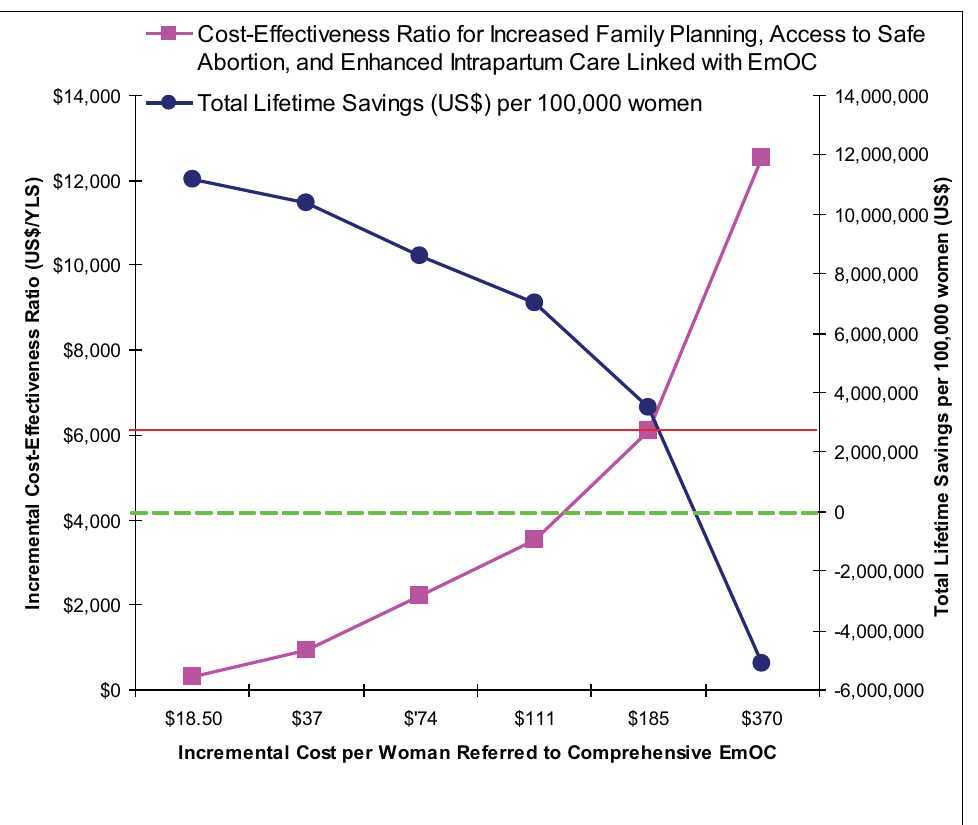
Figure 3. The Impact of Costs Invested in Enhancing Access to EmOC. The additional costs required to enhance access to comprehensive EmOC, expressed as the composite cost of a successfully referred woman, is assumed to include the costs required for ensuring recognition of the need for referral, expedient transport, and ultimate access to an appropriate facility capable of comprehensive EmOC. Shown is the impact of varying the cost per successfully referred woman from $18.50 to $370, on the incremental cost-effectiveness ratios (ICER) for a strategy that includes (1) an increase in family planning from 59% to 74% in women age 20 and older, and from 18% to 33% in women younger than age 20, (2) access to safe abortion for all women who electively terminate a pregnancy; and (3) access to high-quality intrapartum care for all pregnant women and enhanced access to comprehensive emergency obstetric care for at least 90% of women ( pink line ), compared with a strategy only focusing on family planning and safe abortion. Also shown is the impact on the total lifetime savings for a cohort of 100,000 women that could be achieved using this strategy as compared to current practice in Mexico ( blue line ). Provided the incremental cost was below $120 per successfully referred woman, the most effective strategy would be associated with a lower average per-woman lifetime cost than that of current practice ( green dashed line ). Even at a cost of $185 per successfully referred woman ( red solid line ), the incremental cost-effectiveness ratio was less than the Mexico-specific GDP per capita, and would be considered very cost-effective.